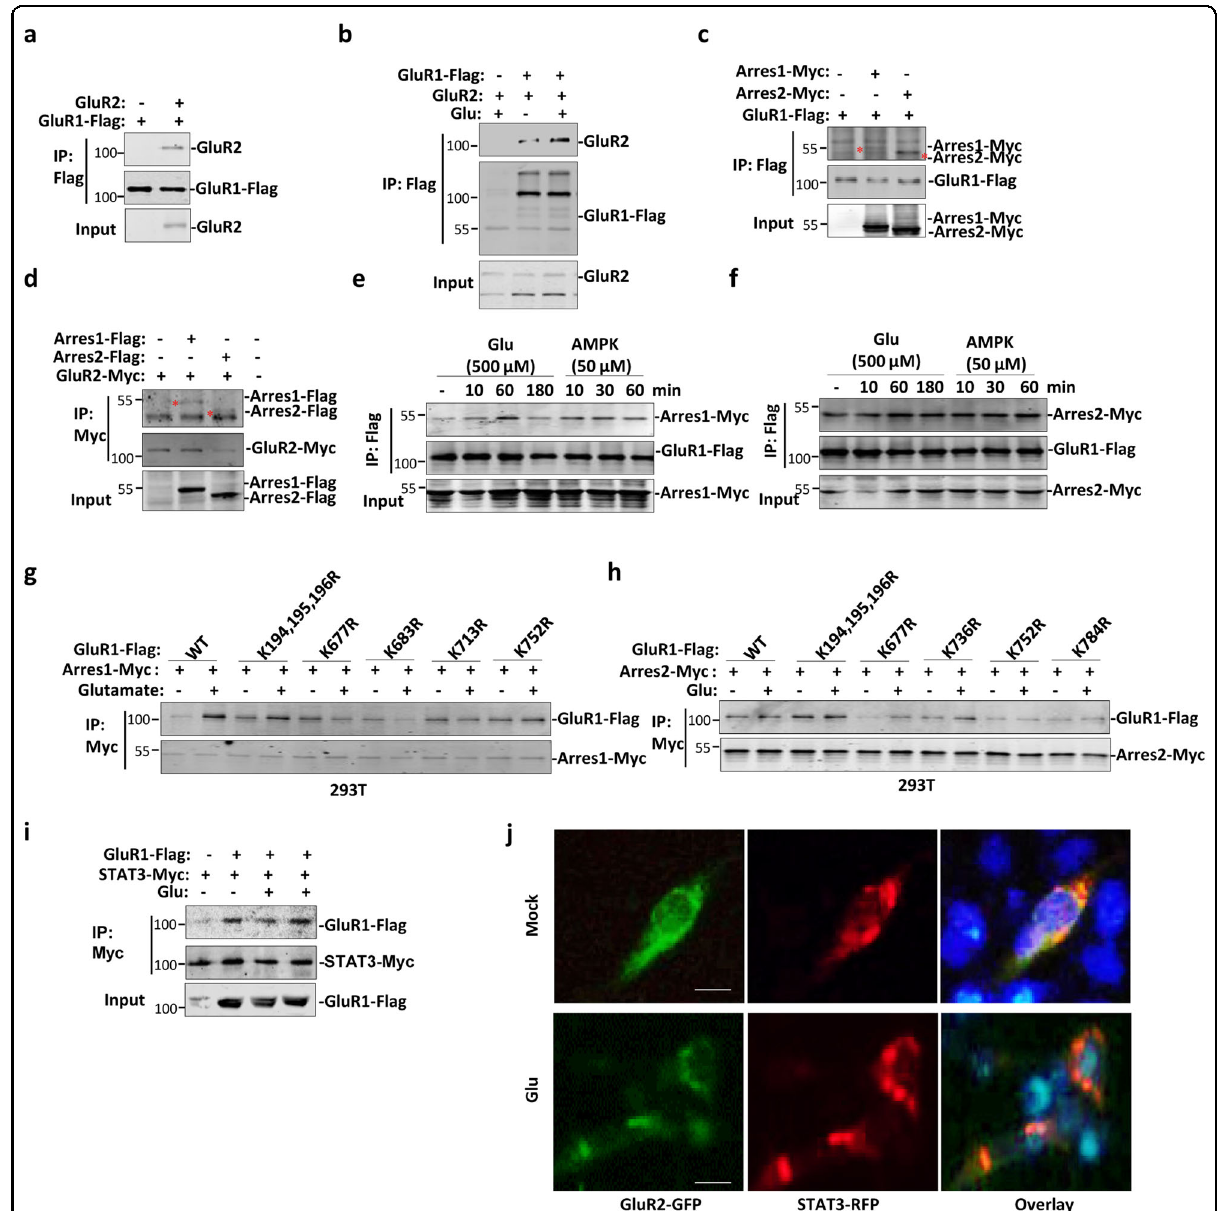
Fig. 3 GluR1/2- β – arrestin1/2 – STAT3 complex formation is dependent on GluR1 and GluR2 acetylation. a 293 T cells were transfected with GluR1 or GluR1 plus GluR2. Cells were subjected to immunoprecipitation with Flag antibody followed by western blot with GluR2 and Flag antibodies. b 293 T cells were transfected with indicated plasmids followed with or without treatment of glutamate. Cells were subjected to immunoprecipitation with Flag antibody followed by western blot with GluR2 and Flag antibodies. c , d 293 T cells were transfected with indicated plasmids. Cells were subjected to immunoprecipitation with Flag antibody followed by western blot with Myc and Flag antibodies. e , f Cells were treated with either glutamate or AMPK for different time, cells were subjected to immunoprecipitation with Flag antibody followed by western blot with Myc and Flag antibodies. Data shown are representative of three independent experiments. g , h Mutation assay of acetylation sites that affected interaction between GluR1 and arrestin1/2. 293 T cells were transfected with indicated plasmids and then were treated with or without glutamate. Cells were subjected to immunoprecipitation with Myc antibody followed by western blot with Myc and Flag antibodies. i 293 T cells were transfected with indicated plasmids and then were treated with or without glutamate. Cells were subjected to immunoprecipitation with STAT3 antibody followed by western blot with Myc and Flag antibodies. Data shown are representative of two independent experiments. j 293 T cells were transfected with GluR2-GFP and Stat-RFP. Localization of GluR2 and STAT3 was observed by microscopy. Scale bar: 10 μ m. Data shown are representative of three independent